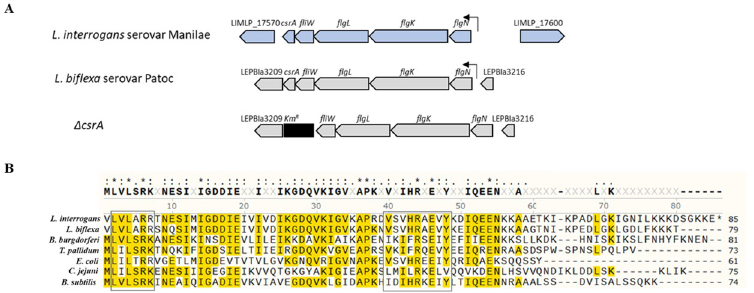
indicate conserved residues that are important for RNA binding in E . coli [62]. Sequences highlighted in yellow indicate the conserved